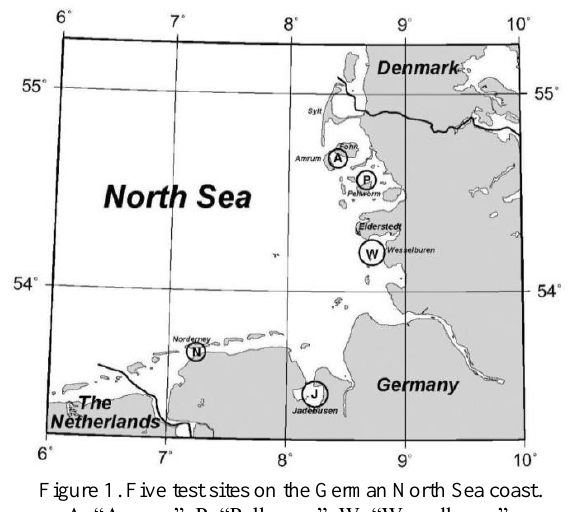
Figure 1. Five test sites on the German North Sea coast.